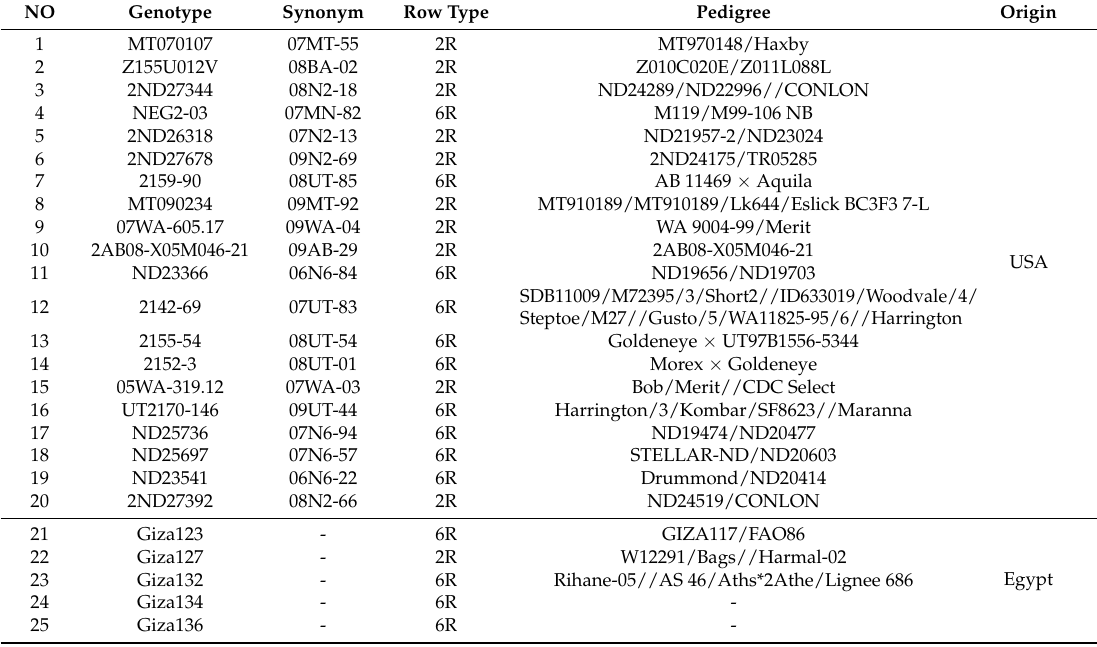
Table 1. Identification and pedigree of the studied barley genotypes: 20 imported genotypes from the United States (USA), and five Egyptian